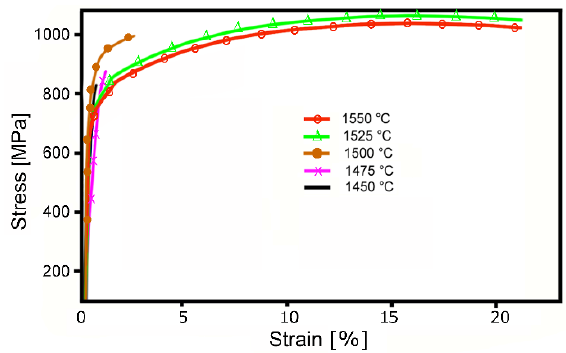
Figure 7. Stress–strain curves for sintered and subsequently quenched pieces.